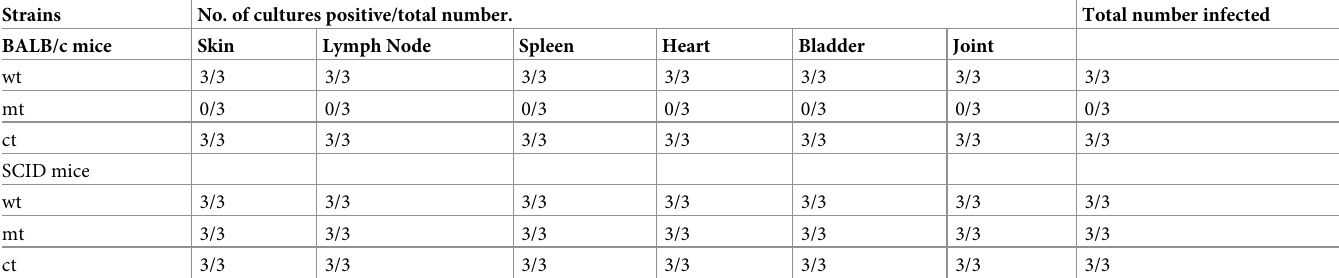
Table 2. Analysis of infectivity of immunocompetent BALB/c mice and immunodeficient SCID mice with wt, mt and ct strains at day 28 post infection. Strains No. of cultures positive/total number.